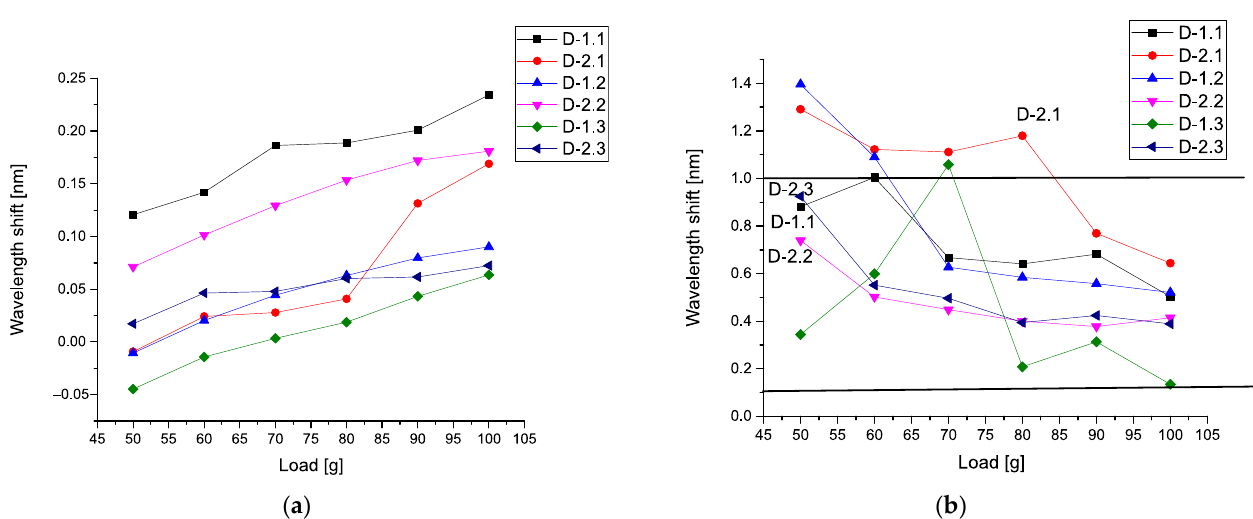
Figure 6. ( a ) Six calibration curves (mean values) calculated for all types of detectors; ( b ) comparison of correlators calculated for different detectors.